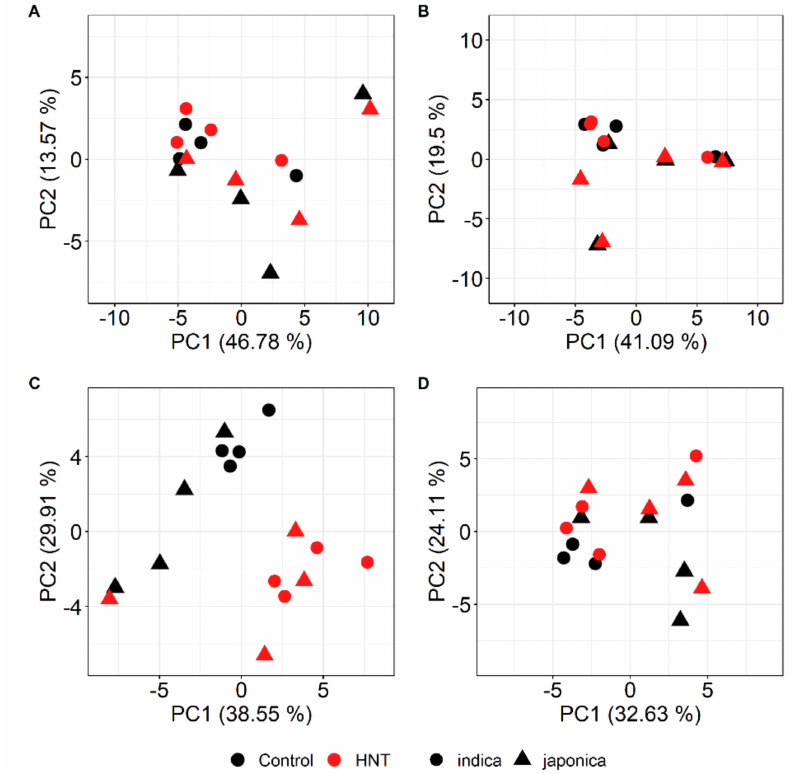
Figure 4. Score plots of the first two Principal Components (PC1 and PC2) from the Principal Component Analysis (PCA) of the metabolite profiles of rice flag leaves ( A , B ) and panicles ( C , D ) of the eight investigated rice cultivars under control and HNT conditions in the WS ( A , C ) and DS ( B , D ). For flag leaves, means of the median-normalized and log 2 -transformed mass spectral intensities of 76 metabolites, and for panicles, those of 69 metabolites, were used. Numbers in parentheses indicate the fractions of the total variance explained by the respective